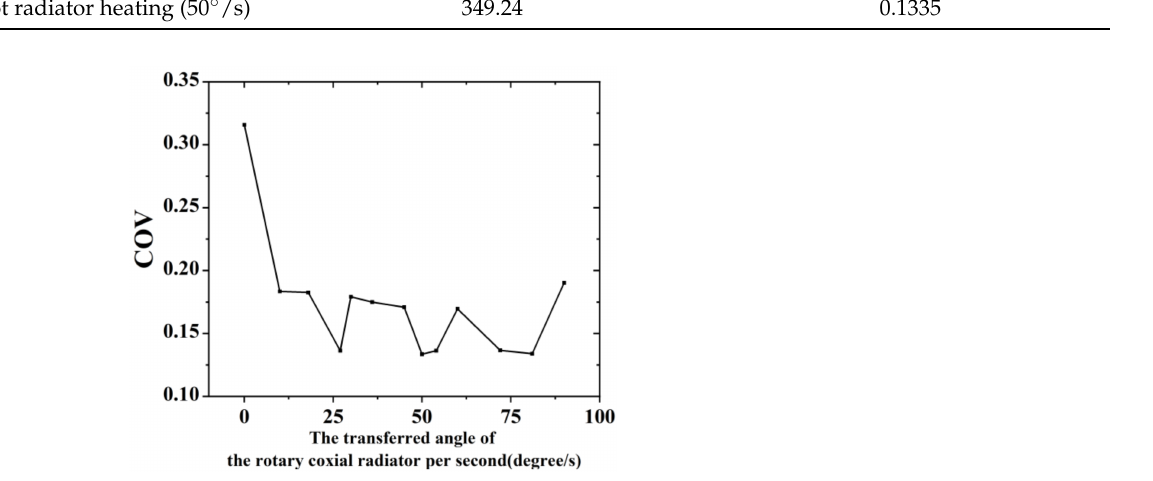
Figure 9. COVsimulationresultsofthesterilizationsystemfordifferentrotationanglevariationspersecond.